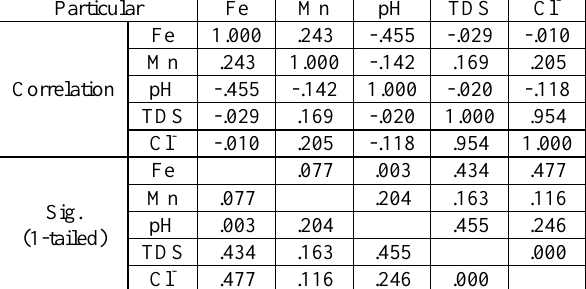
Table 7. Correlation matrix (summer)